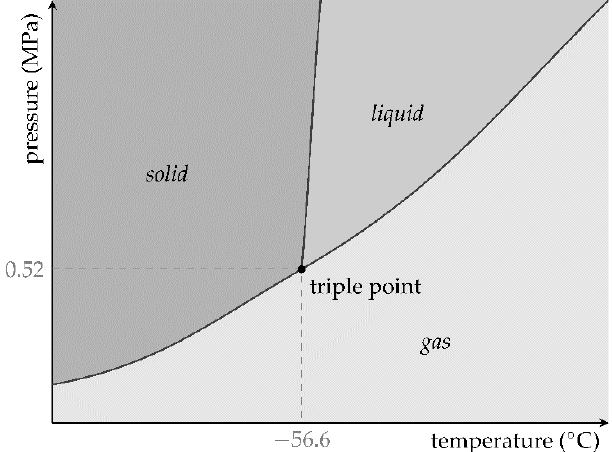
Figure 2. Phase diagram of carbon dioxide with triple point values, based on [18].